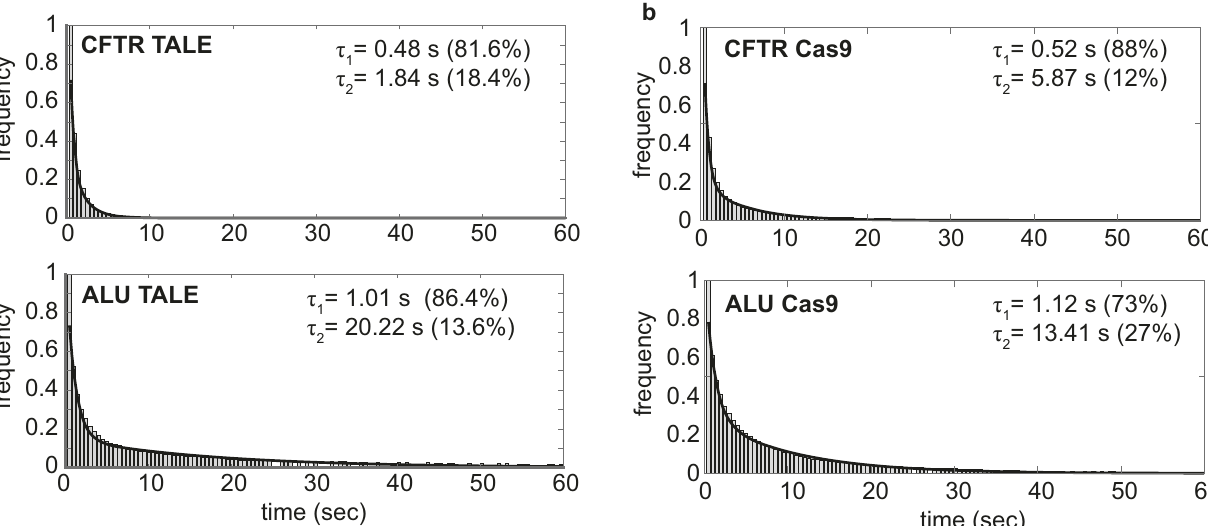
photobleaching (see Methods). Our results show that short-lived